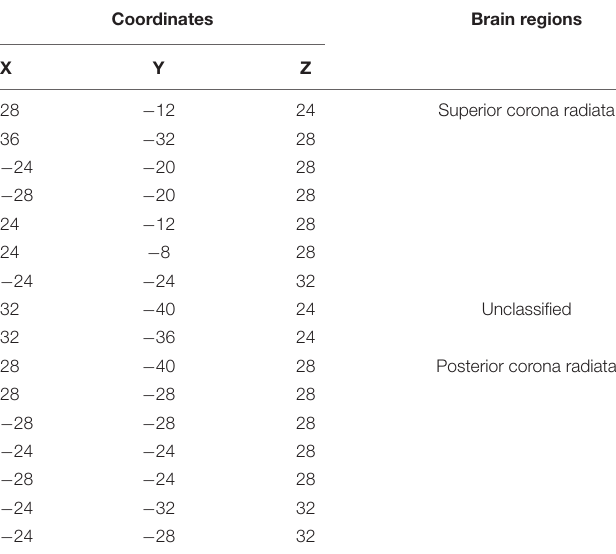
TABLE 1 | Gray matter brain areas with significant differences from the PDH group and control group based on Brodmann atlas. Coordinates